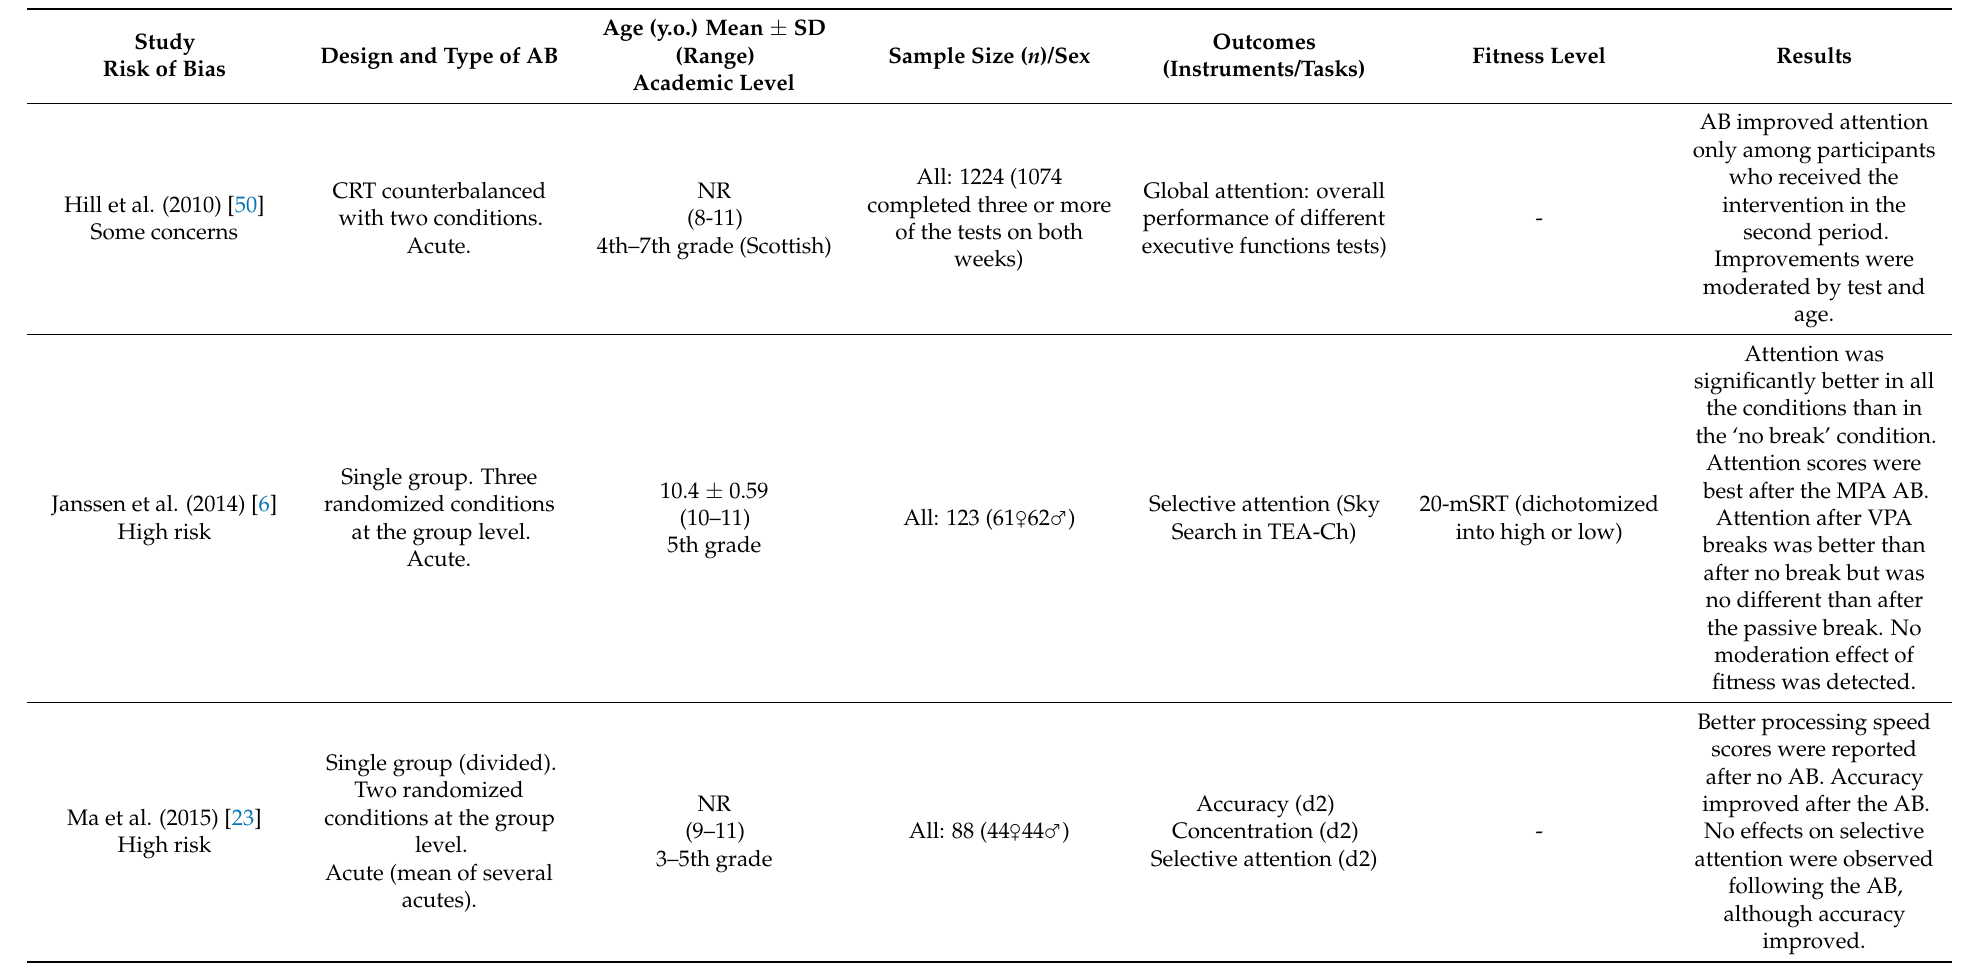
Table 3. Characteristics of the selected studies with a cross-over design